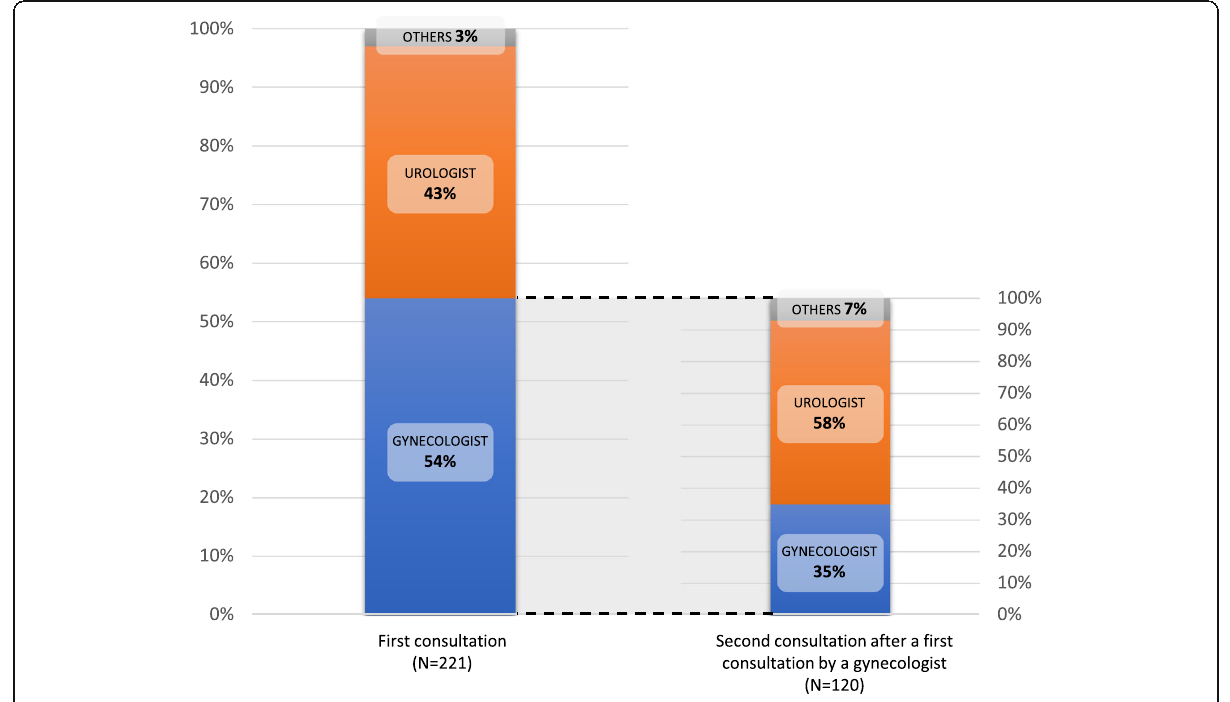
Fig. 1 Who would you go to for first and second consultations (male